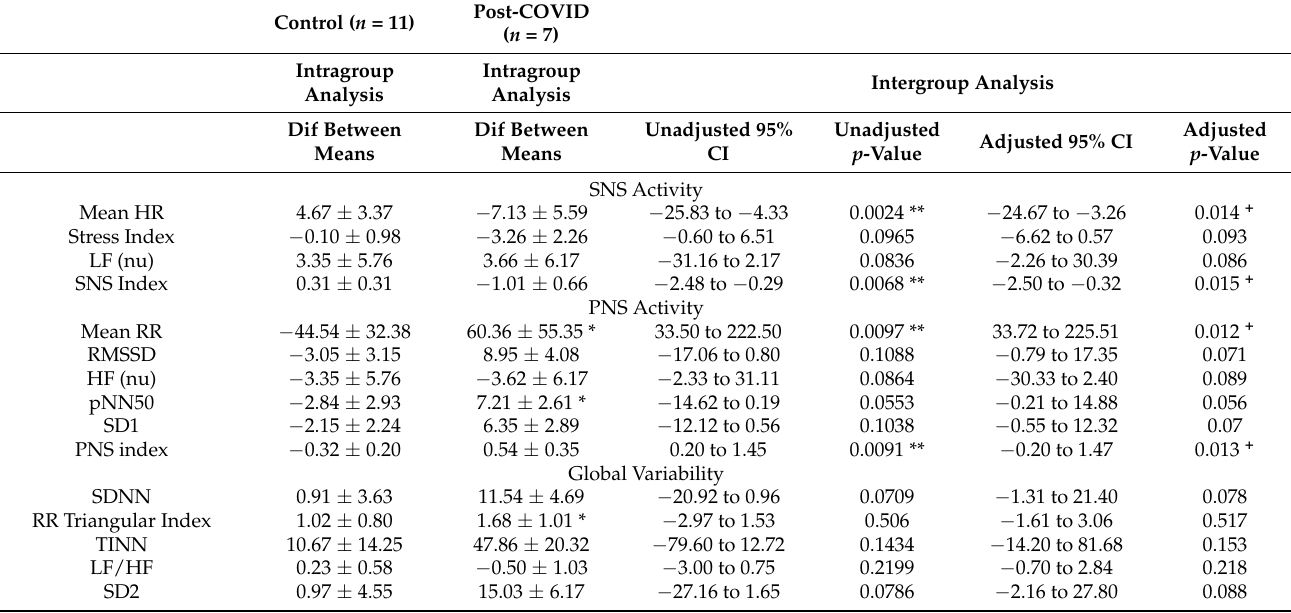
Table 3. Comparisons of change in HRV indexes in the post-COVID and control groups and between